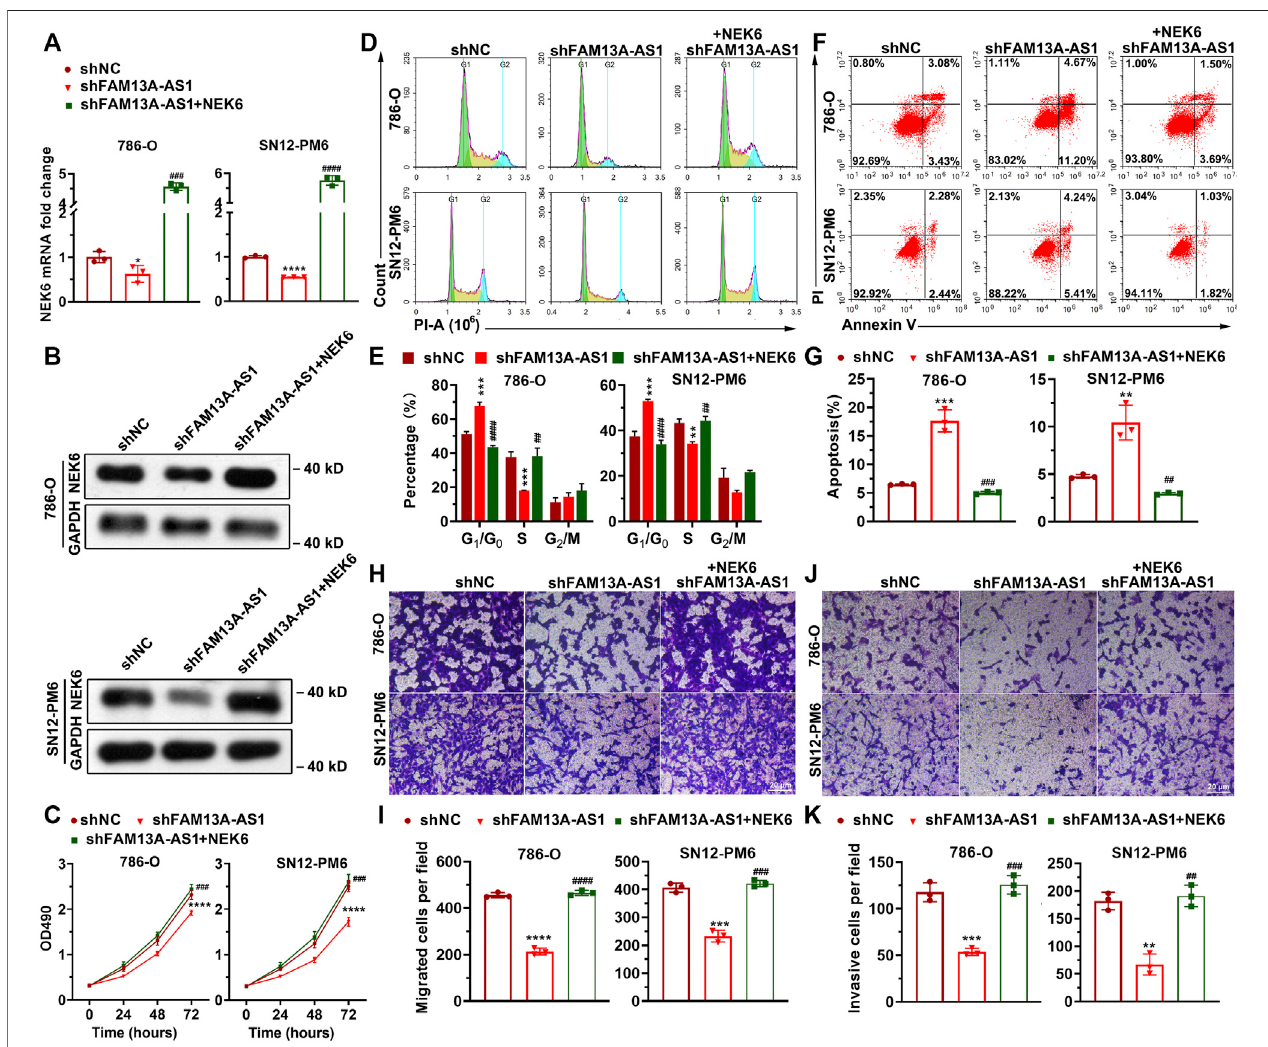
FIGURE7| NEK6isresponsible forFAM13A-AS1-mediated cellproliferation,migration,and invasion. (A) Barplotsshowingtheexpression ofNEK6in786-O and SN12-PM6 cells transfected with shFAM13A-AS1 or negative control (shNC), together with empty vector or NEK6 overexpression plasmid. Expression levels were measured by RT-qPCR. Fold changes of expression were then computed against the scrambled control. (B) Blotting images showing the protein level of NEK6 in the above cells. (C) MTT assay of 786-O and SN12-PM6 cells transfected with shFAM13A-AS1 or negative control (shNC), together with empty vector or NEK6 overexpression plasmid. (D – K) Representative images and quanti fi cations of the fl ow cytometry analysis for cell cycle distribution (D,E) , Annexin V/PI two-parameter fl ow cytometry analysis (F,G) , transwell migration assay (H,I) , and the matrigel invasion assay (G,K) of 786-O and SN12-PM6 cells transfected with shFAM13A-AS1 or negative control (shNC), together with empty vector or NEK6 overexpression plasmid. Data represent the mean ± SD. *: p < 0.05; **: p < 0.01; ***: p < 0.001; ****: p <